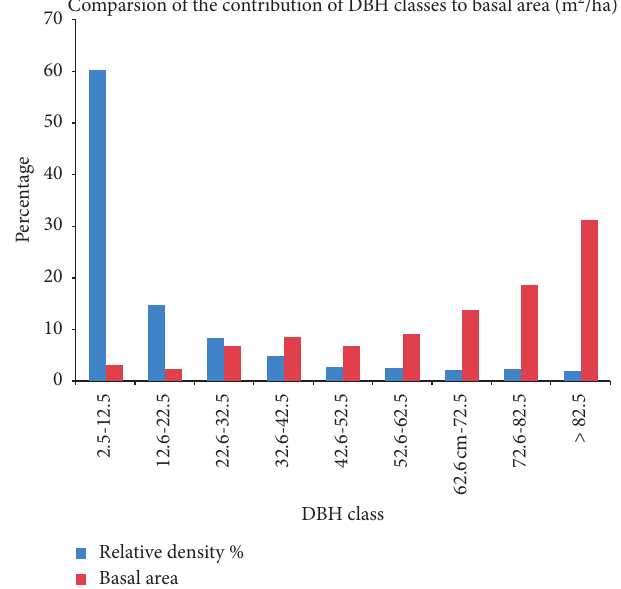
Figure 7: Comparison of the basal area with the different DBH classes of Wurg